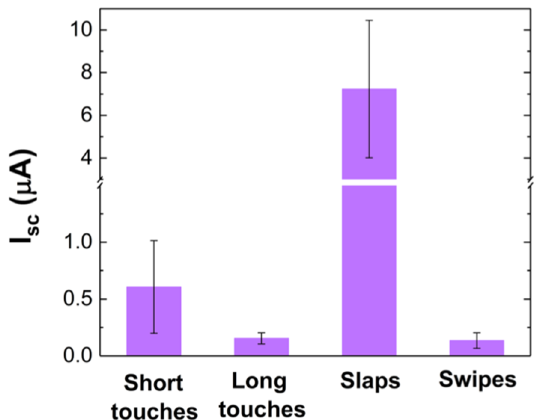
Figure 3. Current output under short circuit conditions for different gestures. Short touches and slaps lasted approximately 0.5 s, while long touches lasted approximately 1 to 1.5 s, and swipes lasted approximately 2 s.